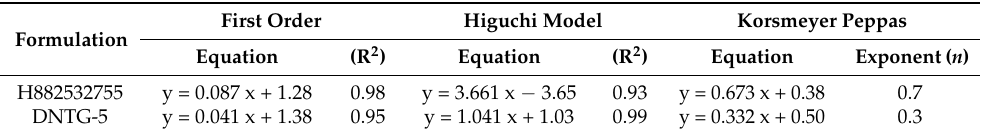
Table 10. Kinetic models of desoximetasone release from the marketed gel and niosomal gel ( n = 6, mean ± SD).